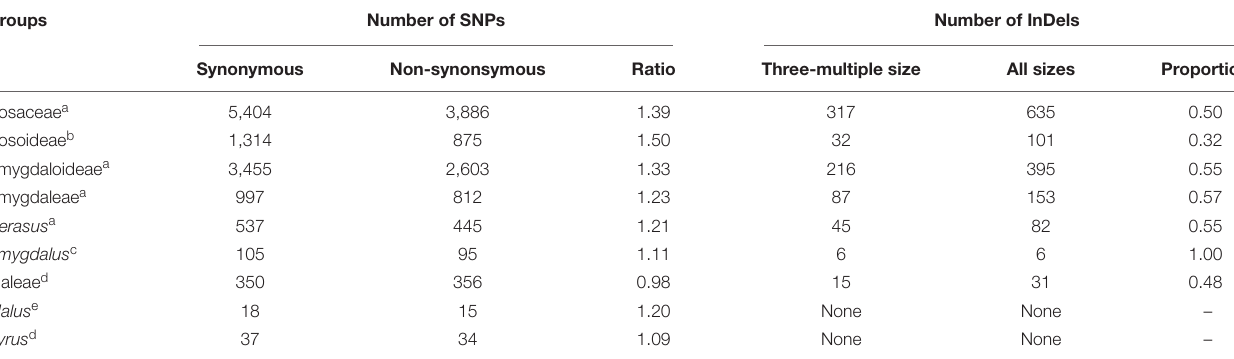
TABLE 3 | Genomic variations distributed in protein-coding regions at different taxonomic levels of